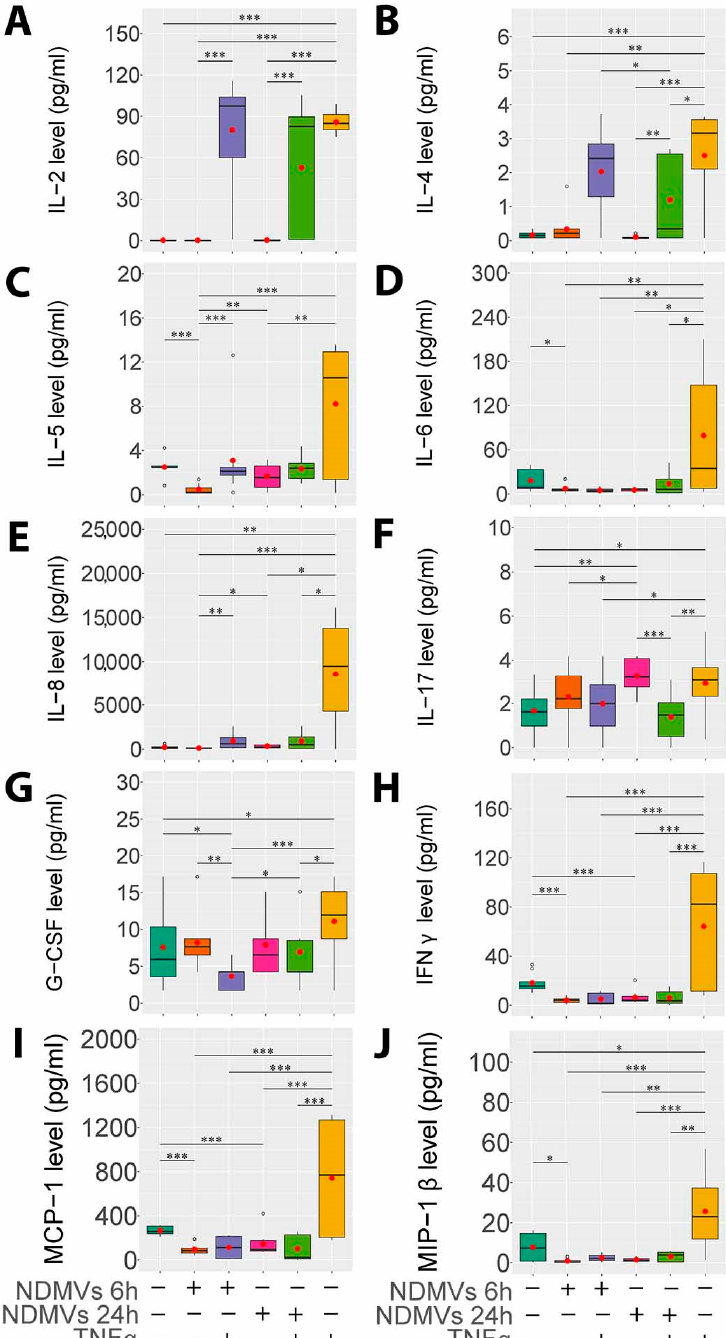
Figure 7. Proinflammatory cytokine and chemokine levels in FLS and NDMV culture supernatants. (A, B, C, D, E, F, G, H, I, J) show IL-2, IL-4, IL-5, IL-6, IL-8, IL-17, G-CSF, IFN γ , MCP-1 and MIP-1 β levels, respectively, in culture medium after incubation with or without treatment. TNF α also sig-nificantly elevated cytokine levels after incubation are as follows: control; + NDMVs 6 h - TNF α ; + NDMVs 24 h - TNF α ; + NDMVs 6 h + TNF α ; + NDMVs 24 h + TNF α ; and + TNF α 24 h. Cytokine levels were analyzed using the Kruskal–Wallis test followed by the Conover–Inman test. Box plots indicate the interquartile ranges (75th to 25th IQR) of the data. The median values are shown as lines within the box, the outlier values are indicated by round circles ( ◦ ), and the mean values are indicated by red dots ( ● ). Five independent experiments were performed in different FLS clones. * p < 0.05; ** p < 0.01; *** p < 0.001.